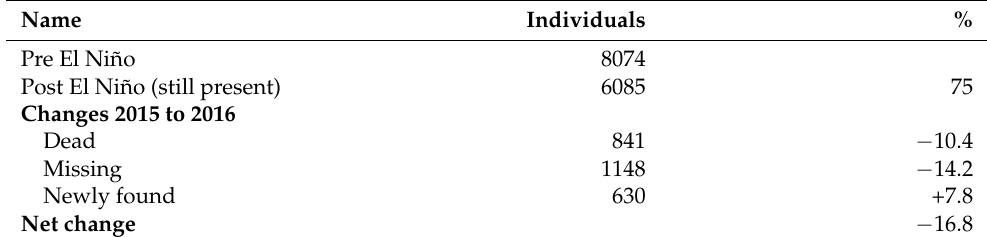
Table 1. Changes in the number of epiphyte individuals before and after the El Niño event. Percent- ages are based on the total number of individuals found before the El Niño event. The last row gives the net change from 2015 to